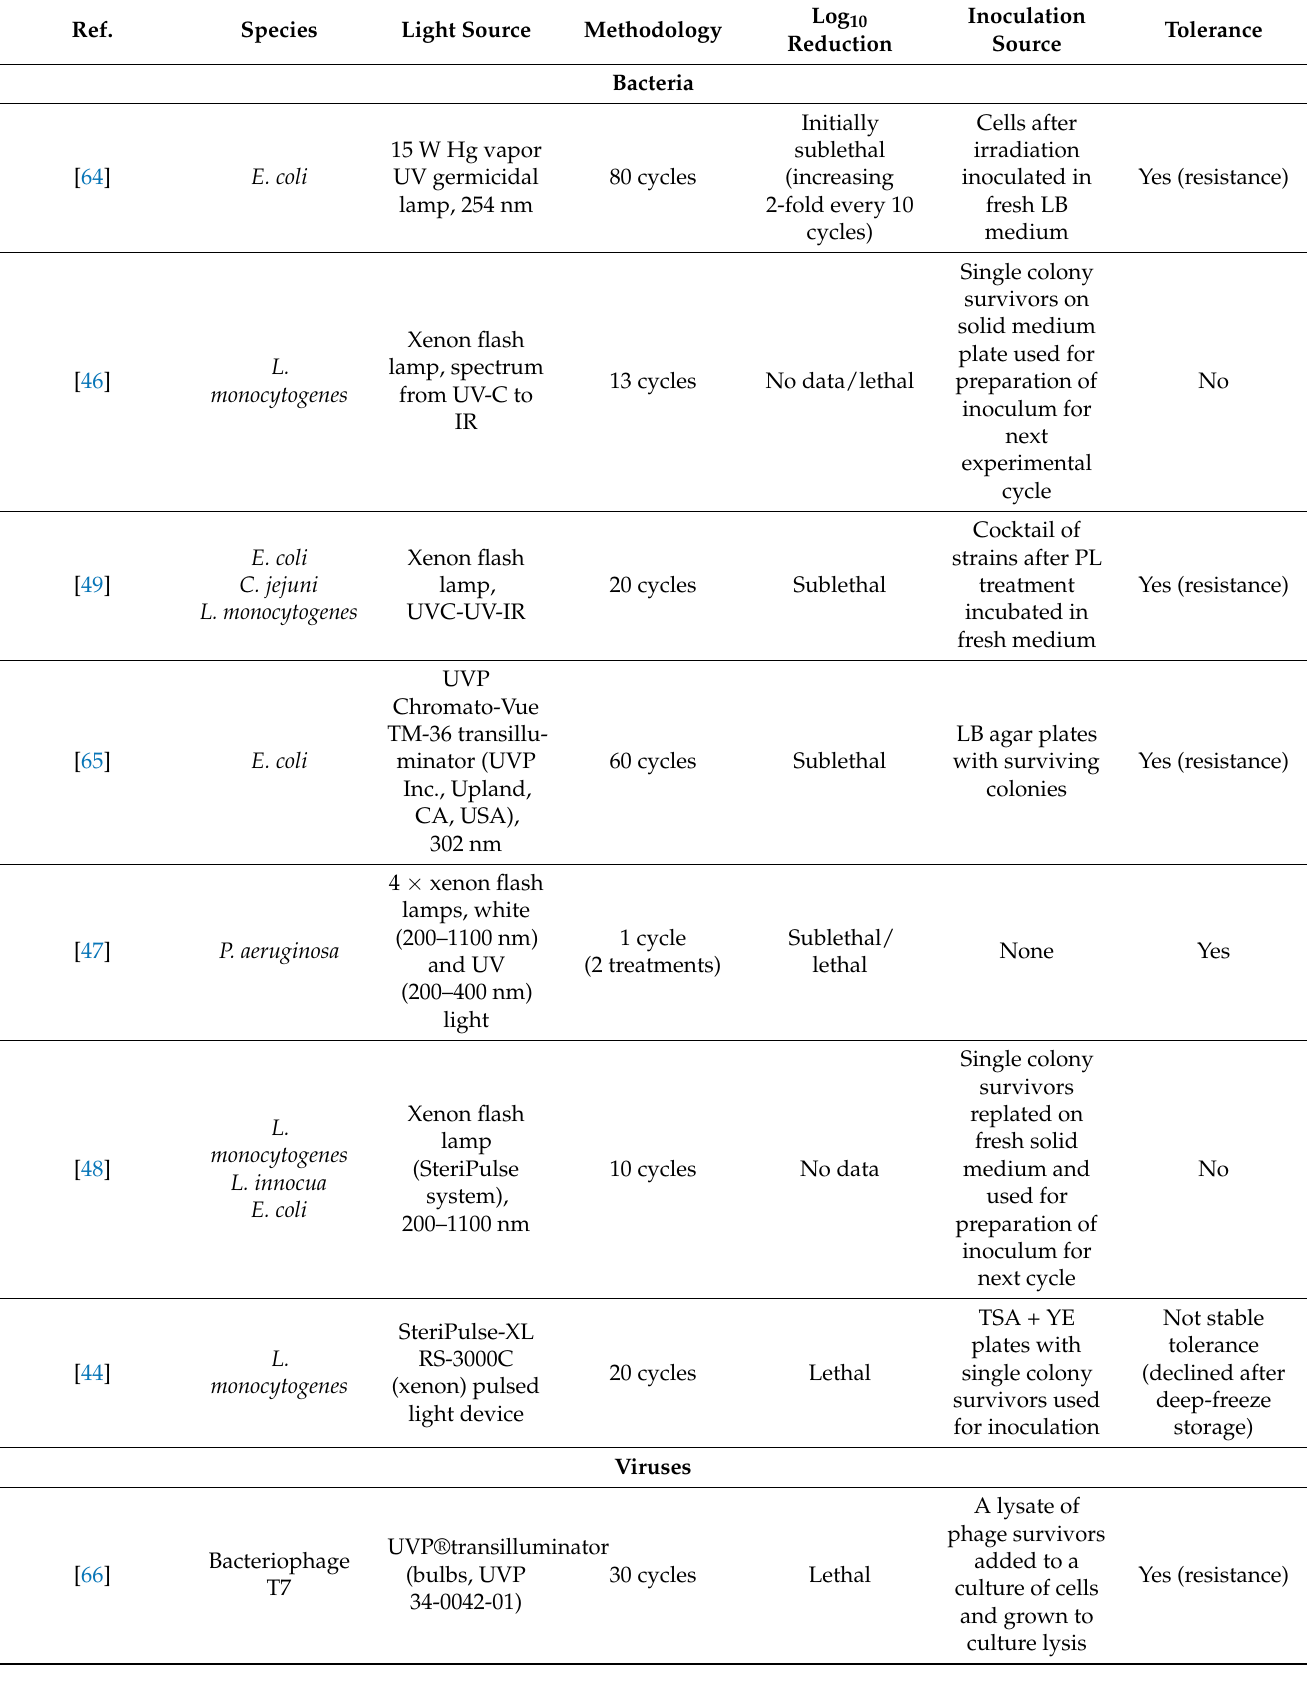
Table 3. Ultraviolet